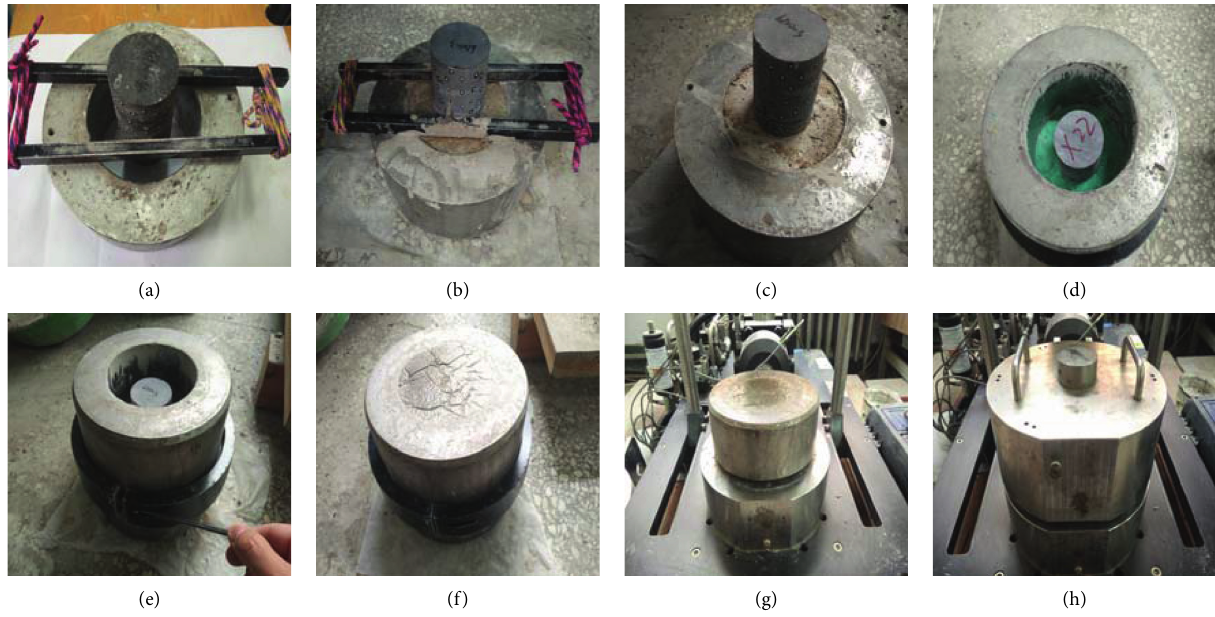
Figure 4: Shear sample preparation for interblock and intrablock sample. (a) Rock sample with fracture vertical suspension in the lower shear ring using clamping tools. (b) Pouring grout into the shear ring, and the fracture surface is higher than the end surface of the shear ring. (c) Completion of grout consolidation and removal of clamping tools. (d) 0.5cm thick layer of rubber mud is formed onto grout surface. (e) Placing the upper shear ring and aligning and fixing the upper and lower shear rings. (f) Pouring grout into the upper shear ring, waiting for solidification. (g) Placing the shear ring in the lower shear box. (h) Covering the upper shear box for a shear test.